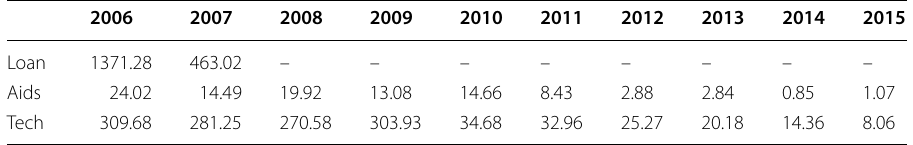
Table 2 Environmental ODAs from Japan to China (in 100 million JPN yen). Source : Minis- try of Foreign Affairs of